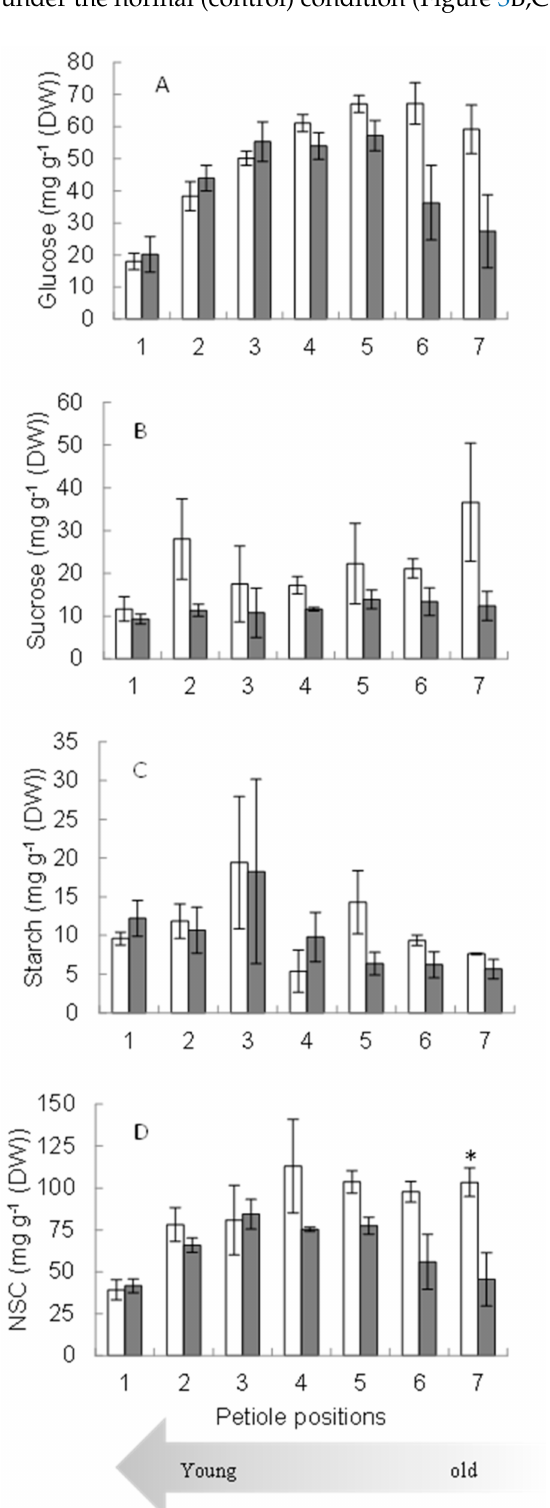
Figure 3. Glucose ( A ), sucrose ( B ), starch ( C ), and NSC ( D ) concentration at different petiole